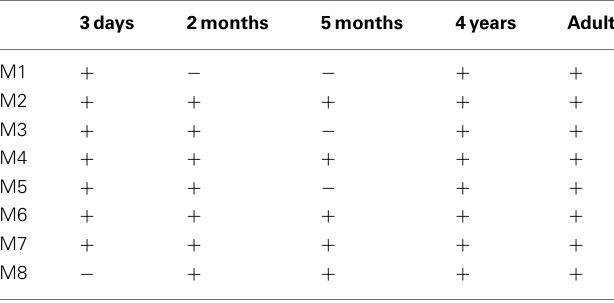
Table 1 | Qualitative metabolite profiles from hepatocyte